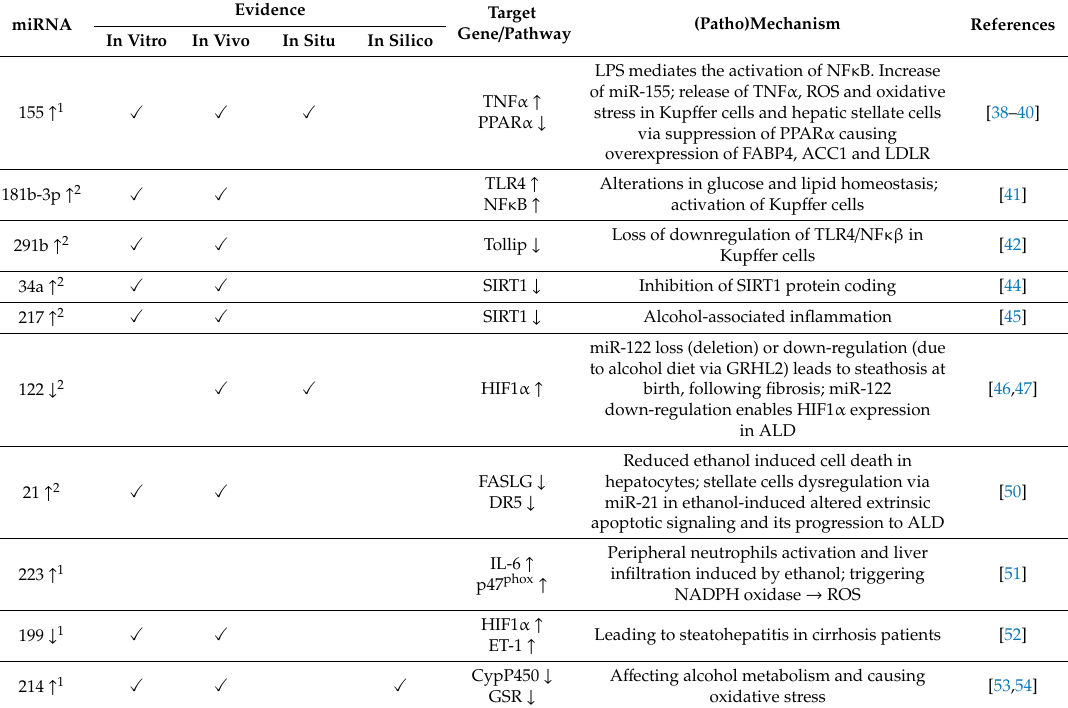
Table 2. Deregulated miRNAs and relation to OS in ALD /